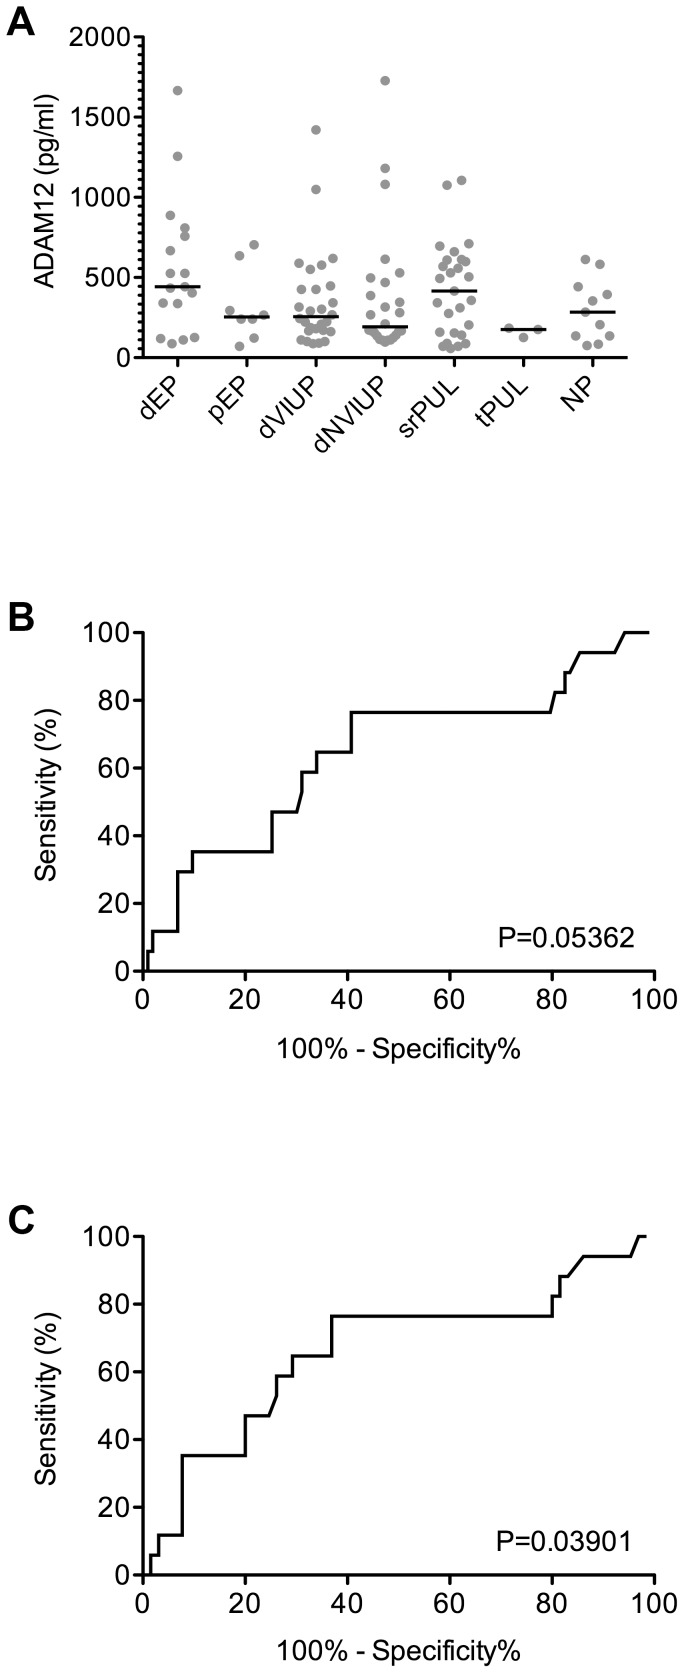
ADAM12 levels in sera collected from women at first presentation with a PUL, categorised according to final pregnancy outcome.Definite ectopic pregnancy (dEP: n = 17), probable ectopic pregnancy (pEP: n = 8), definite viable intrauterine pregnancy (dVIUP: n = 28), definite nonviable intrauterine pregnancy (dNVIUP: n = 26), spontaneously resolving PUL (srPUL: n = 27), treated persistent PUL (tpPUL: n = 3) and not pregnant (NP: n = 11). A ROC curve was generated (‘ROC of ADAM12’) to compare serum ADAM12 concentrations in patients with a dEP versus all other outcomes. The analysis was repeated (‘ROC of ADAM12 -PUL Data’) after ‘ambiguous’ pregnancy outcomes (srPUL, tpPUL and pEP) were excluded.